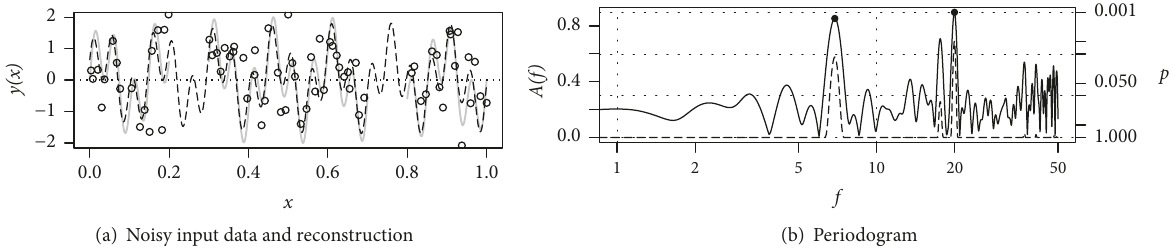
Figure17:Randomlysampleddatawithnoiseandgaps.Theboldgraylinein(a)isthediscontinuoussignal.Thecirclesrepresentthesampling points, which are overlaid with some strong noise and jitter. The dashed line represents the reconstruction. In (b) the corresponding Lomb- Scargle periodogram is given. The black line is the amplitude spectrum and the dashed line indicates 𝑝 . The black points show the amplitude maxima, which the filter.lomb() function chose for